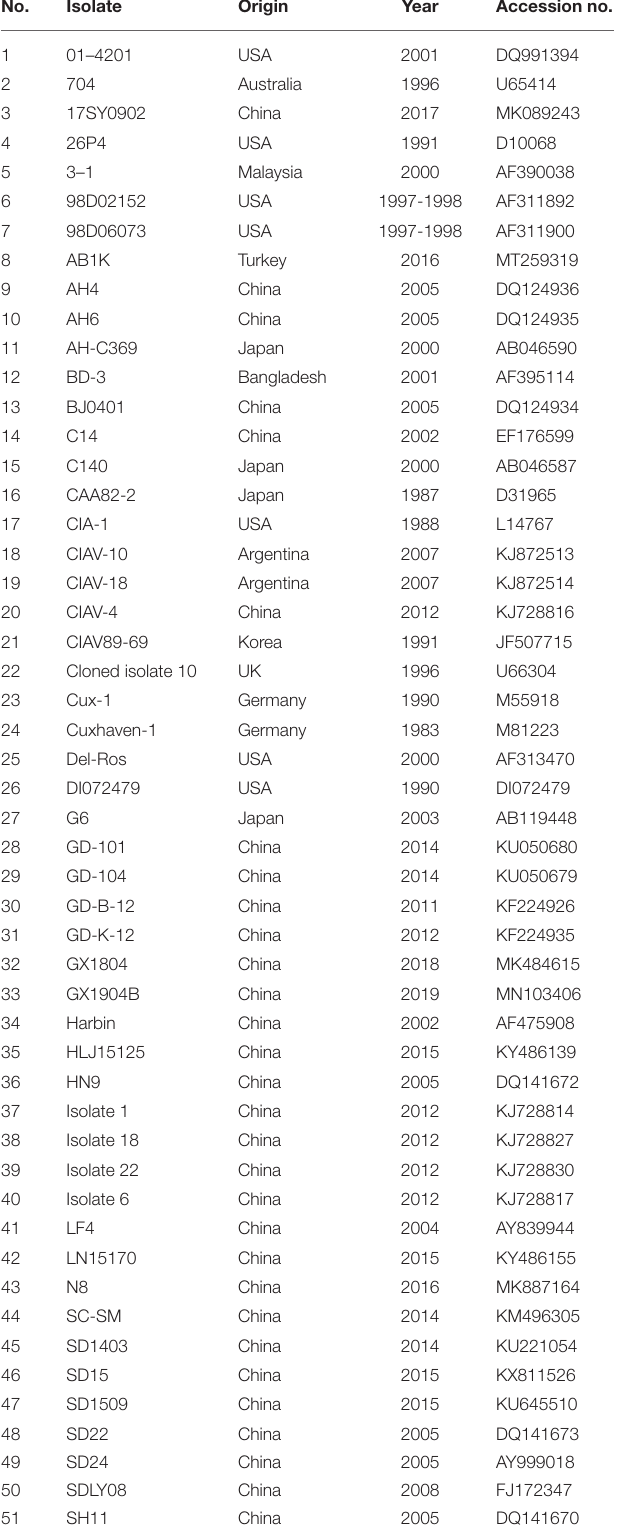
Three overlapping genomic segments were amplified from DNA extracted from the PCR-positive pooled organs using three pairs of primers ( Table 2 ) (41) to establish the full-length nucleotide sequences. The PCR amplification was carried out in a 25 µ L total PCR reaction volume containing 10 pmol of each